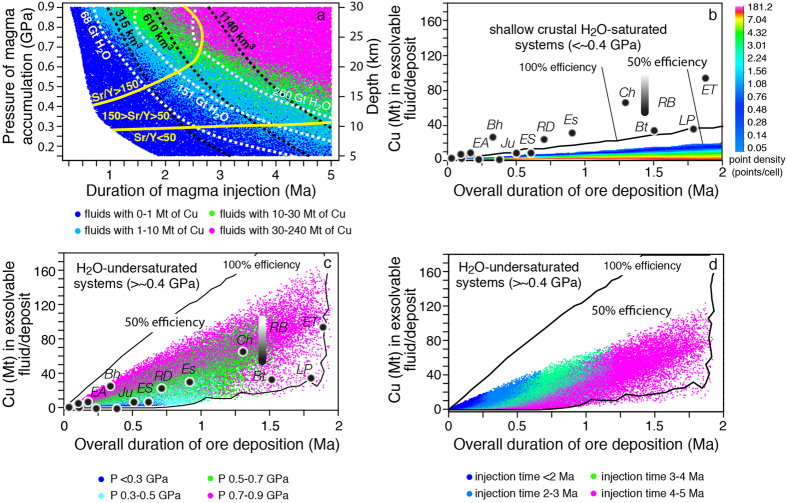
Monte Carlo simulations of porphyry Cu productive and non-productive magmatic systems under an average arc magma flux of 0.0009 km3/a.(a) Pressure versus time conditions for the generation of magmatic systems with different Cu potential endowments (white and black dashed lines indicate the Gt of H2O dissolved in the hybrid melt and hybrid melt volume in km3, respectively; yellow lines represent limits of Sr/Y values of hybrid melts resulting from our simulations); (b) Monte Carlo simulations of Cu (Mt) in excess fluid versus duration of magmatic cycle for H2O-saturated magmatic systems formed at crustal depths <~0.4 GPa. The black dots represent radiometrically measured timescales of porphyry Cu deposits with respect to their endowment (Table S1.1). The onset of the mineralization has been placed in correspondence with the beginning of magma accumulation to allow comparison of the two timescales. For abbreviations of PCD see Table S1.1; (c) Cu (Mt) in the exsolvable fluid of hybrid melts after injection times of 0 to 5 Ma versus the overall duration of the ore deposition period. Color classes indicate different pressures of magma accumulation; (d) same as (c) but with colour codes indicating different times of magma accumulation.